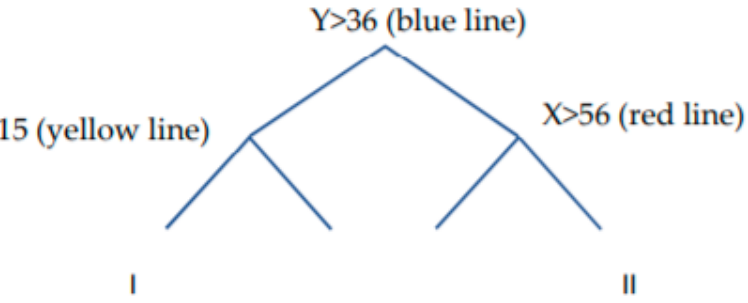
Figure 4. The example decision tree showing a tree depth of two. The labels (such as Y > 36) describe the decision boundary at a node.